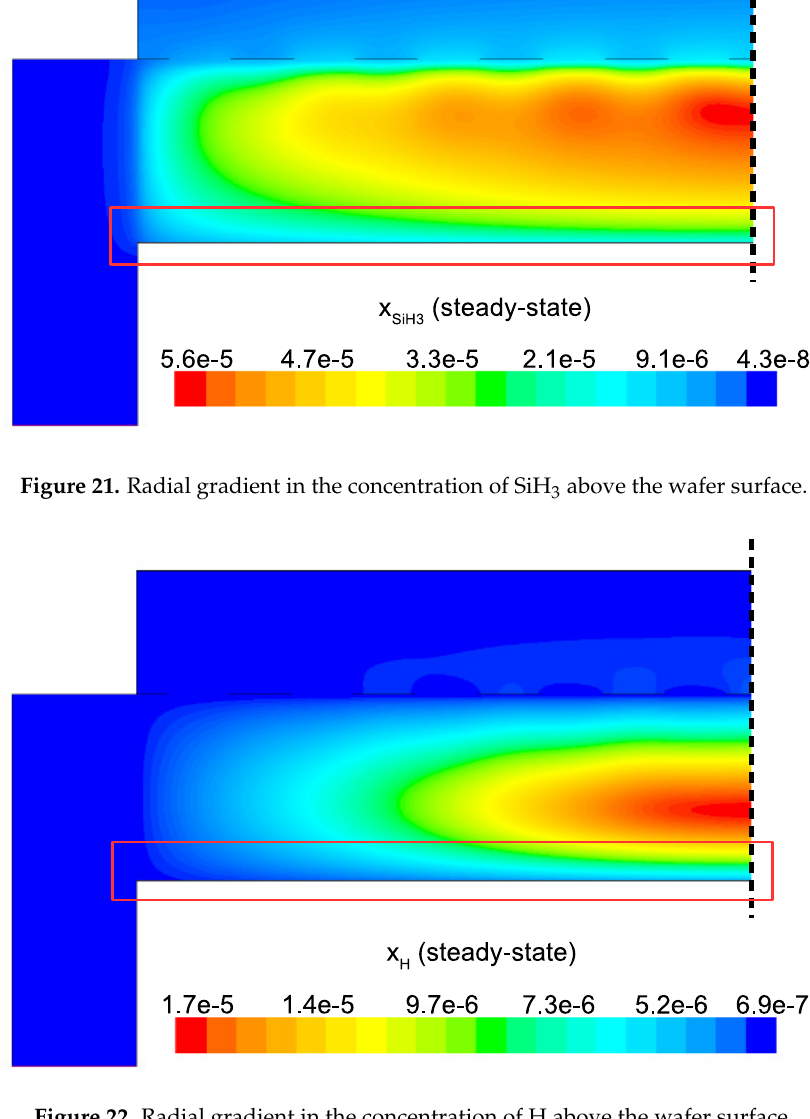
Figure 22. Radial gradient in the concentration of H above the wafer